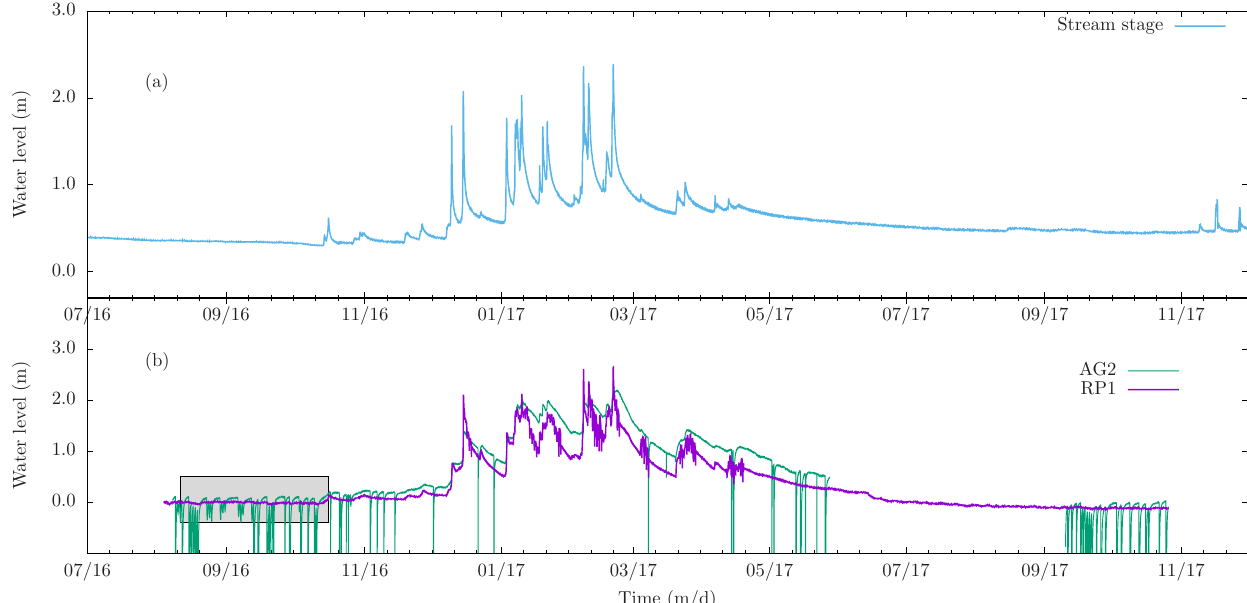
Figure 10. Comparison of water level fluctuations in ( a ) Scotts Creek and ( b ) piezometer (RP1) and an irrigation well (AG2), from August 2016 to November 2017. To facilitate comparison, the water levels plotted in ( b ) were referenced to the first recorded data point in each respective time series. The large drawdown responses ( ≥ 15 m) in the top graph are those of well AG2 water levels to pumping in AG2. Data in the gray box are shown in Figure 11